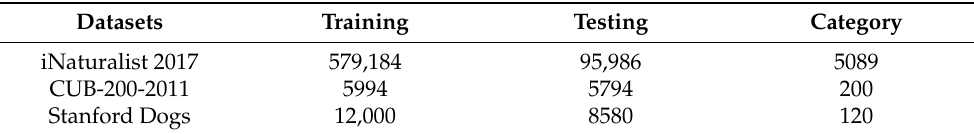
Table 1. Statistics of three datasets.